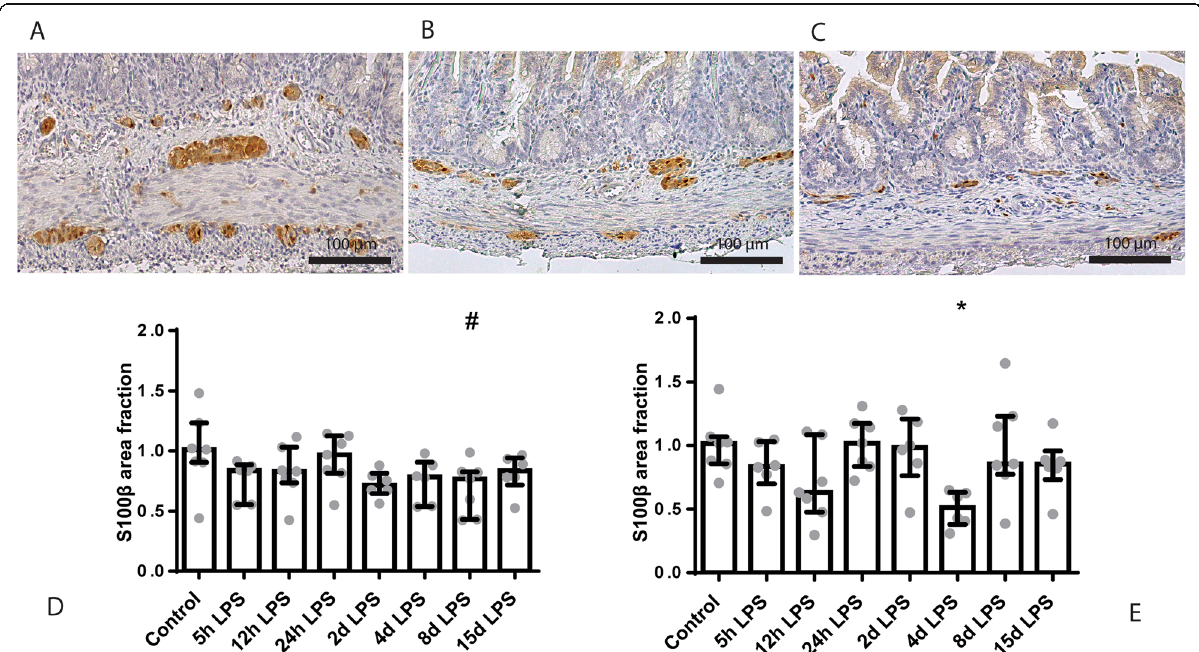
Fig. 7 Representative images of S100 β immunoreactivity in the submucosal and myenteric plexus of the control ( a ), 4 days of IA LPS ( b ) and 8 days of IA LPS group ( c ). Area fraction of S100 β in the submucosal ( d ) and myenteric plexus ( e ) as fold increase over the control value. d S100 β - positive surface area tended to be decreased in animals exposed to 8 days of IA LPS. # p = 0.09 compared to control. e S100 β -positive surface area is decreased in animals exposed to 4 days of IA LPS. * p < 0.05 compared to